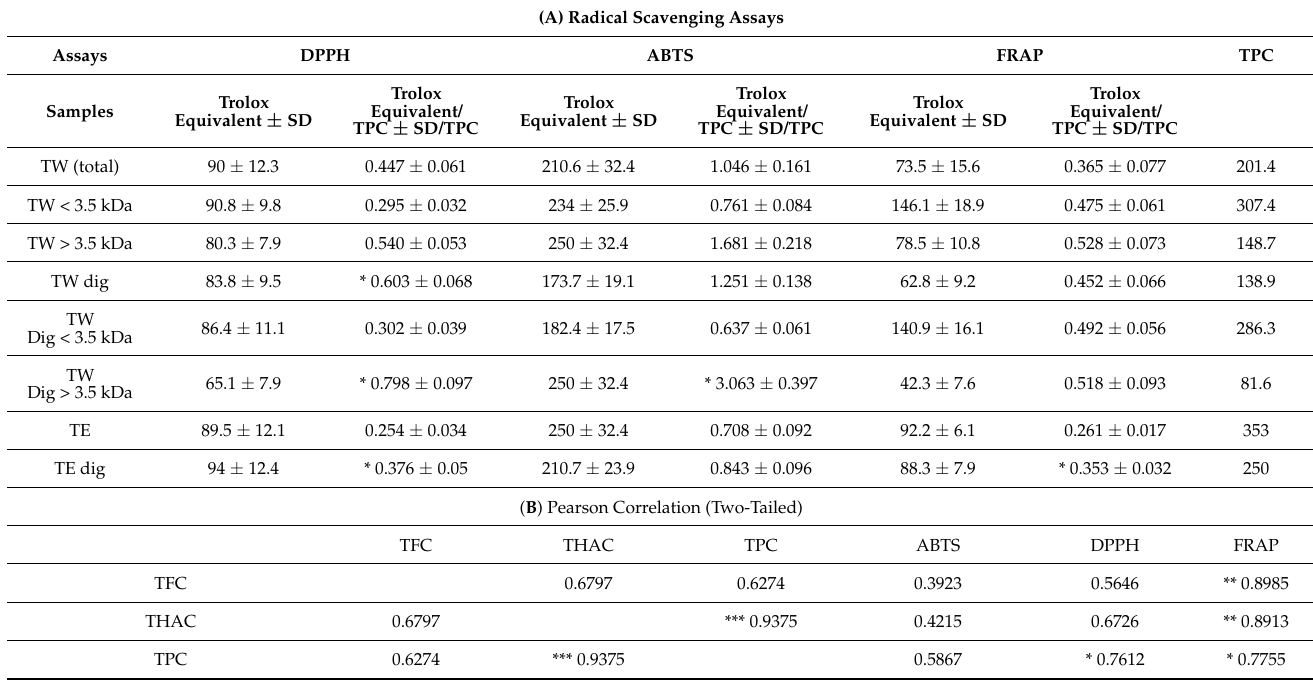
Table 3. (A) The radical scavenging activity of the T. spicata extracts before and after digestion. Values are reported as Trolox equivalent ( µ g TE/mg dry extract). (B) Pearson correlation (two-tailed) between TFC, THAC, TPC, and antioxidant parameters (DPPH, ABTS, and FRAP). All values are mean ± SD from at least three independent experiments. Samples were measured in triplicate for each experiment. Significance is denoted by symbols: * p < 0.05, ** p < 0.01, and *** p < 0.001.